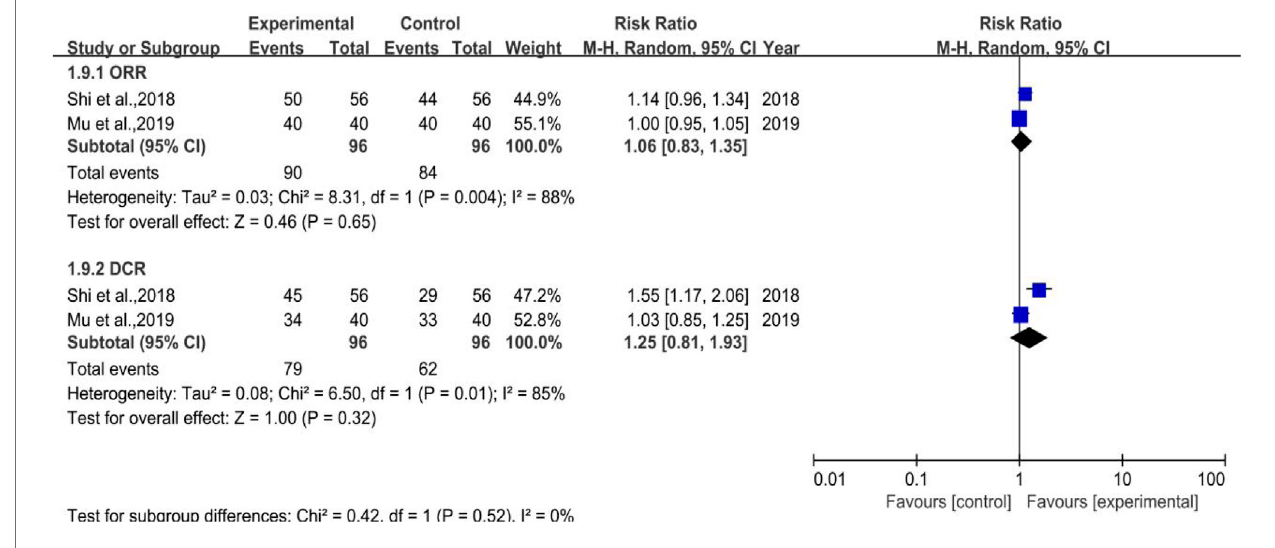
FIGURE 11 | The forest plot of ORR and DCR in preventive medication.